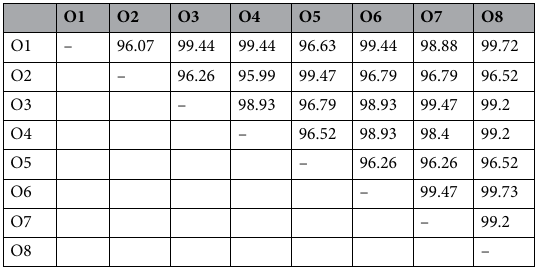
Table 2. Percent sequence similarity between V4 and V5 representative sequences for each oligotype.